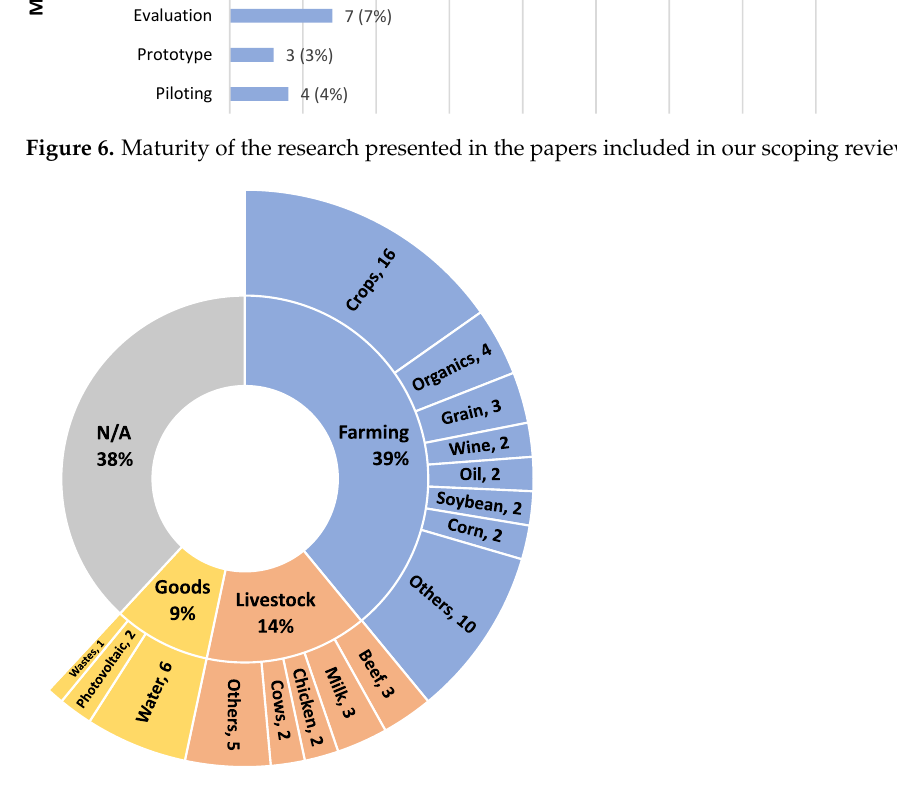
Figure 7. Agriculture sector and products addressed in the papers included in our scoping